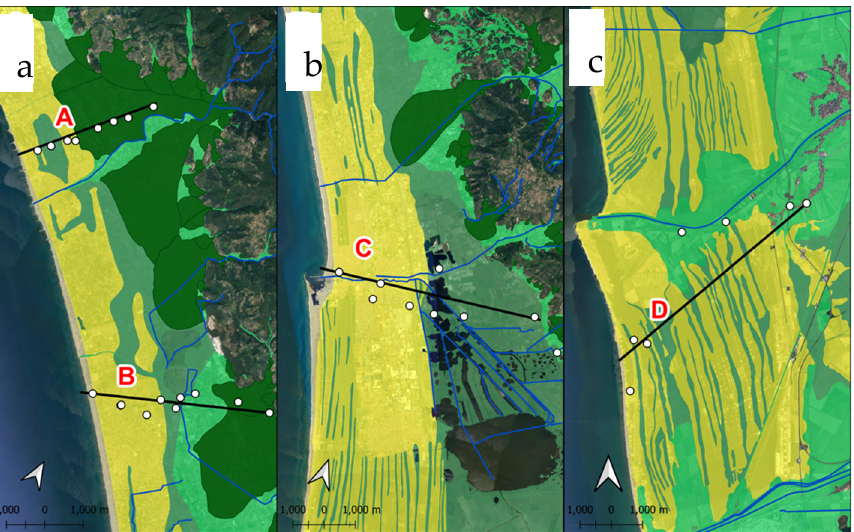
Figure 3. Location of the transects along which the four stratigraphic sections are produced. ( a ) Lo- cation of Sections A and B; ( b ) location of Section C; and ( c ) location of Section D. The white circles represent the locations of the boreholes used for the stratigraphic sections.